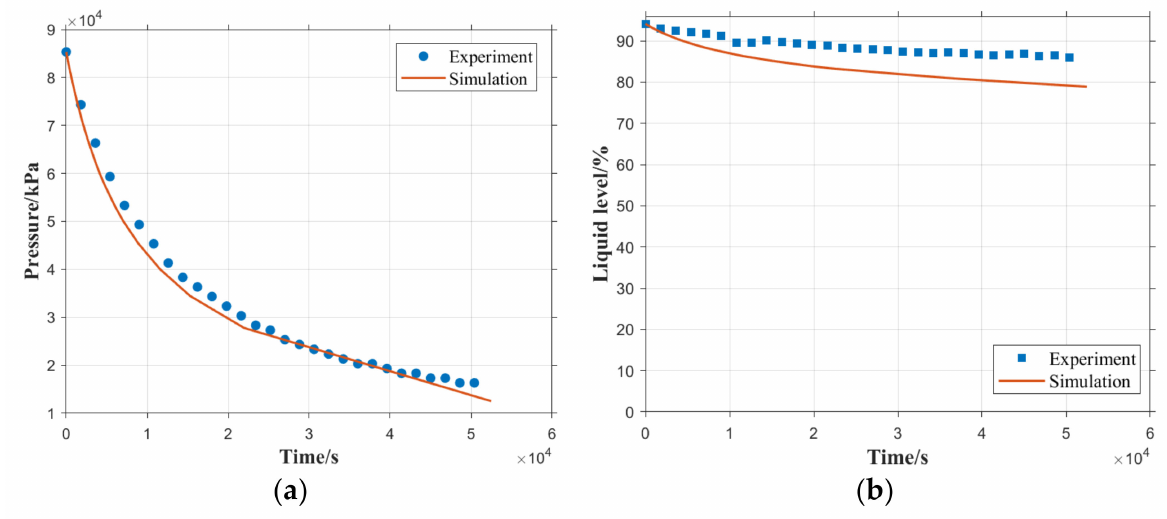
Figure 4. Comparison of simulation and experimental data: ( a ) tank pressure deviation and ( b ) tank liquid level